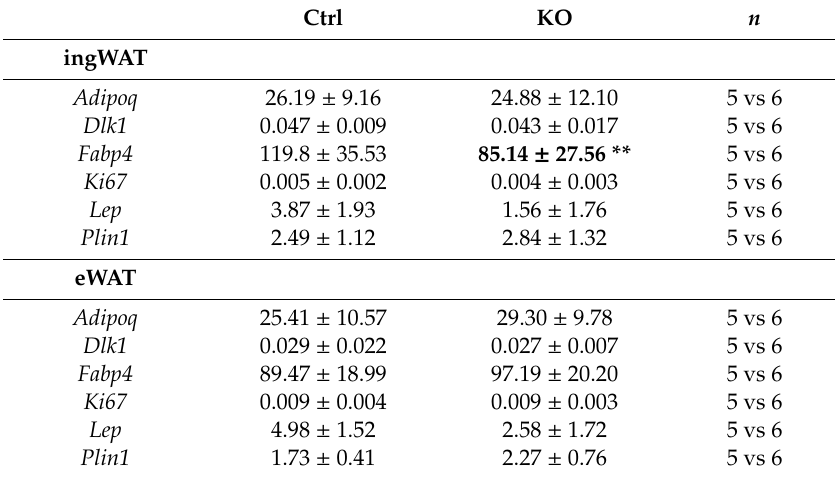
Table 2. Gene expression measurements in ingWAT and eWAT of HFD male mice. Gene expression was normalized for 36b4 gene expression as the housekeeping gene. Ctrl KO n ingWAT Adipoq 26.19 ± 9.16 24.88 ± 12.10 Dlk1 0.047 ±